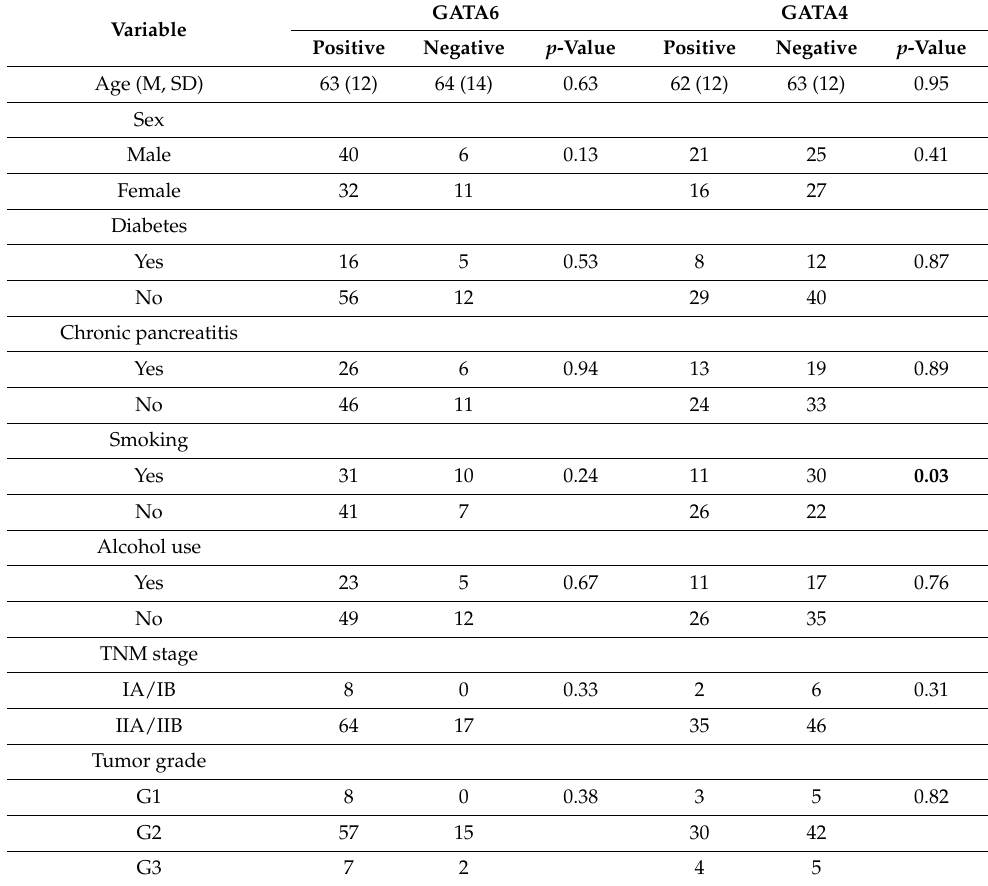
Table 2. Patients’ clinical characteristics and GATA6 & GATA4